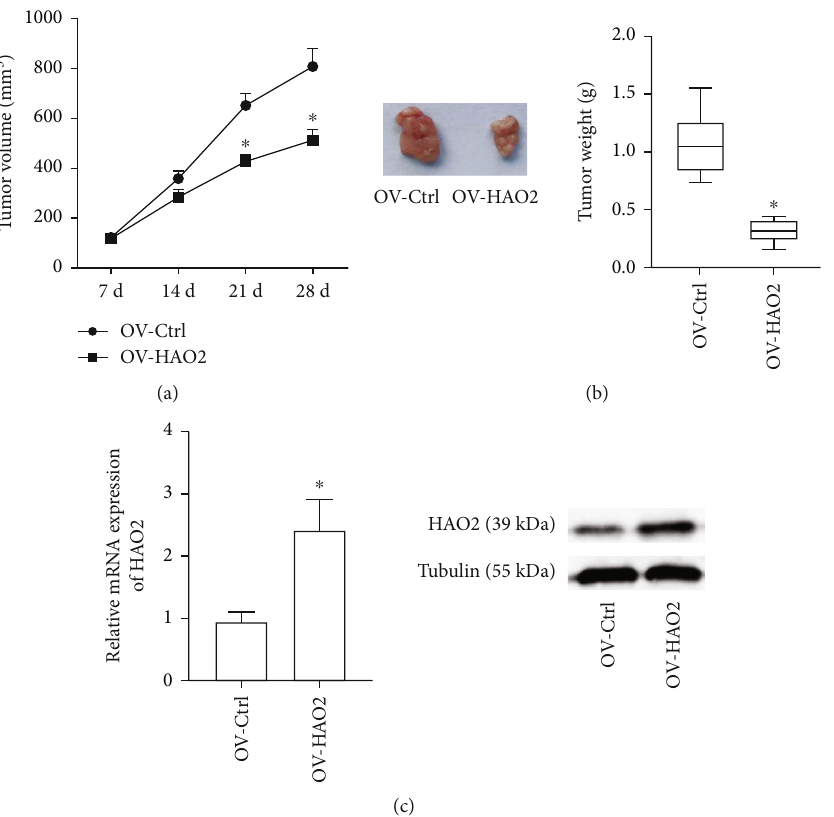
Figure 5: Exogenous expression of HAO2 reduces the tumorigenicity of HCC cells in vivo. (a) The HCC cells in the OV-NC group formed tumors in nude mice, while the tumor growth of the HCC cells in the OV-HAO2 group was signi fi cantly inhibited. (b) The tumor weight in the OV-HAO2 group was signi fi cantly decreased compared with the OV-NC group. (c) The mRNA and protein levels of HAO2 in tumors of the OV-HAO2 group were overexpressed compared with those of the OV-NC group. ∗ P < 0 : 05